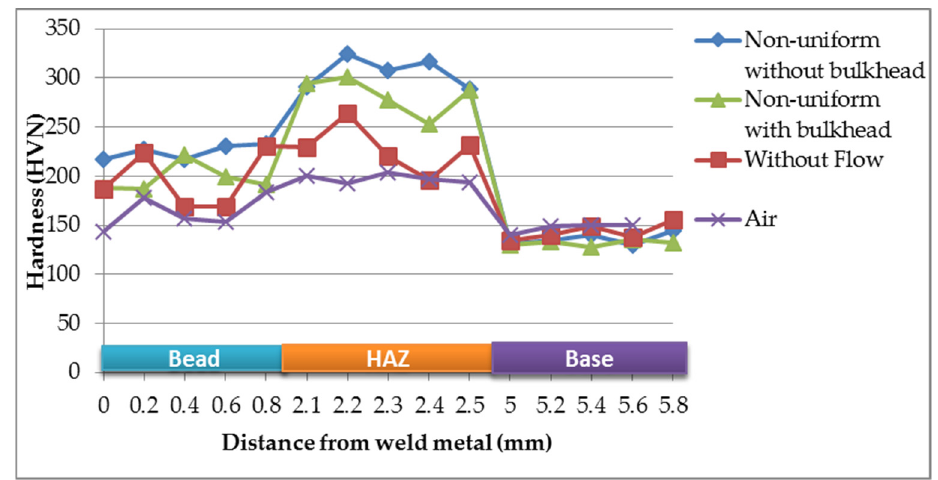
Figure 8. Hardness test results for the proposed specimen.